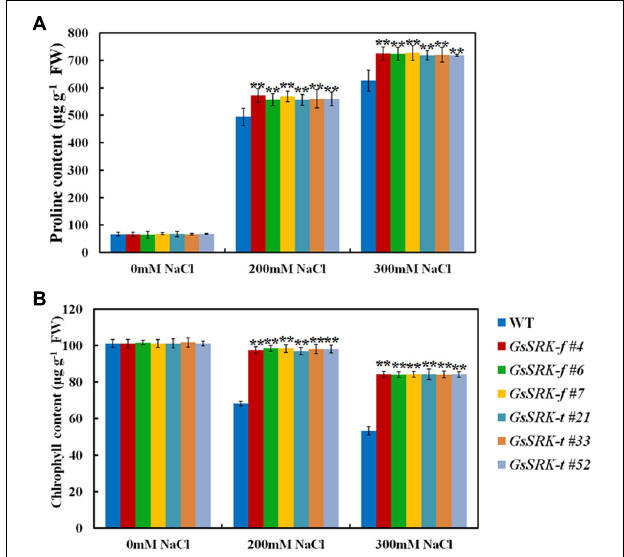
FIGURE 7 | Effect of GsSRK-f and GsSRK-t overexpression on proline and chlorophyll accumulation. (A) The proline content of the WT and transgenic alfalfa under control conditions and salt stress. (B) The total chlorophyll content of the WT and transgenic alfalfa under control conditions and salt stress. Data are means ± SE ( n ≥ 6). ∗∗ P < 0.01 by Student’s t